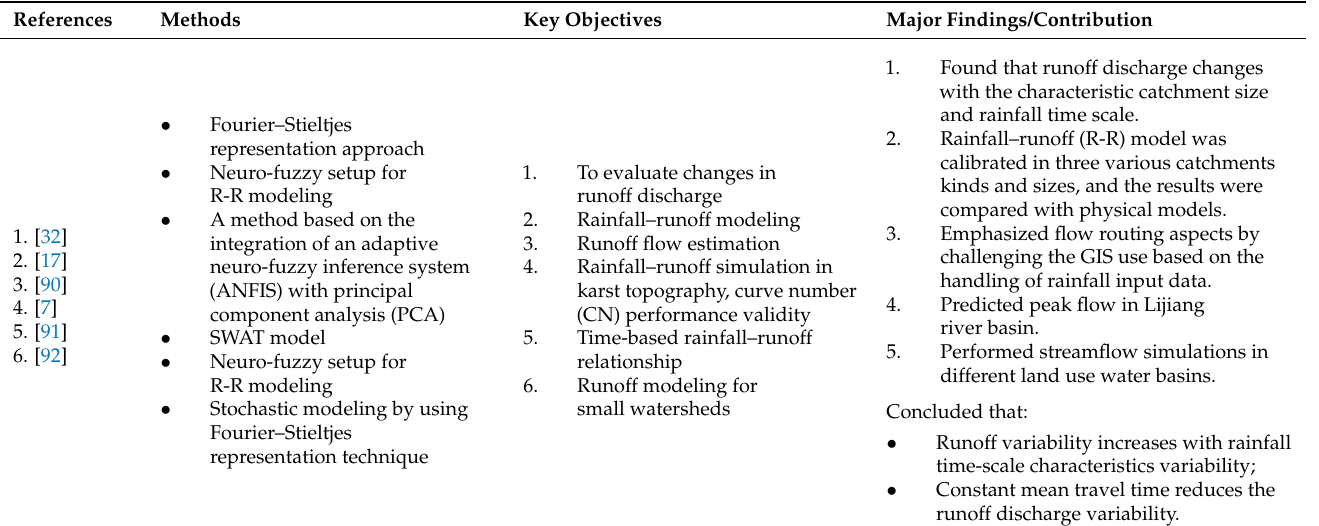
Table 3. State-of-the-art methods used for rainfall runoff simulation since